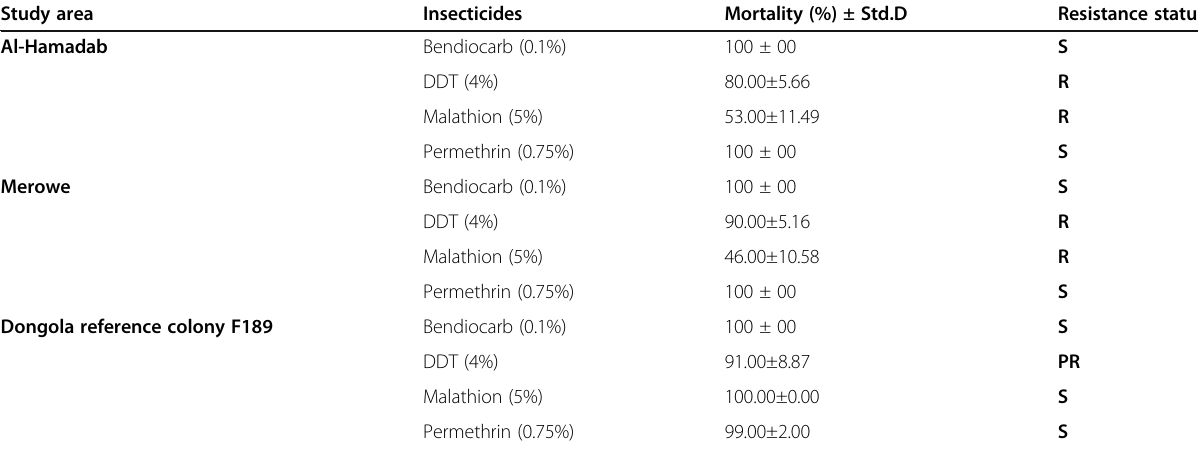
Table 1 WHO standard bioassay test on Anopheles arabiensis Study area